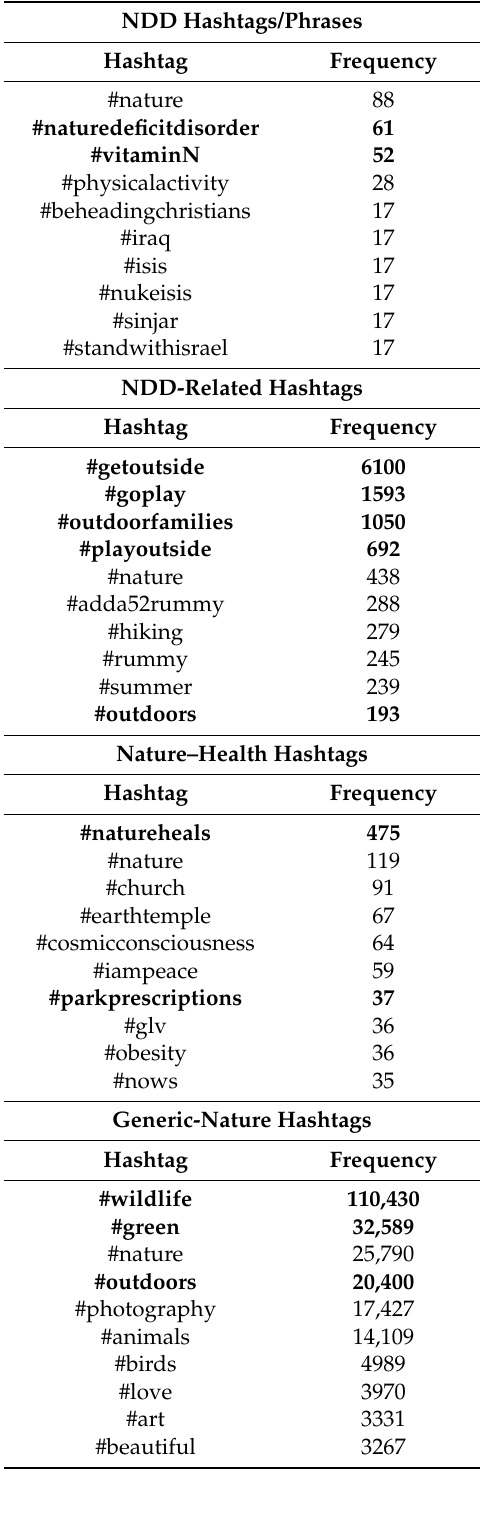
Table 10. Most frequent hashtags per